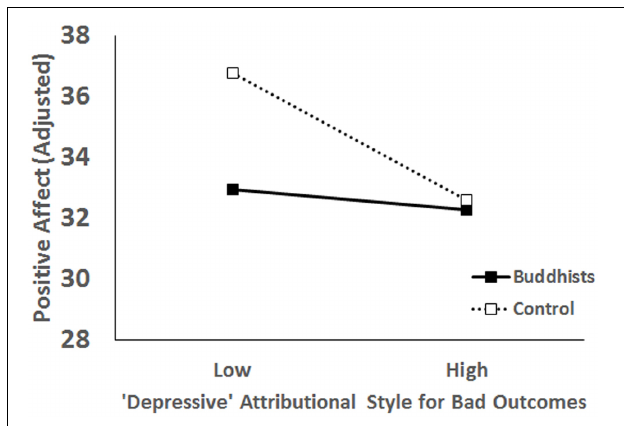
FIGURE 2 | Interaction effect of the depressive attributional style and Buddhist beliefs on positive affect.